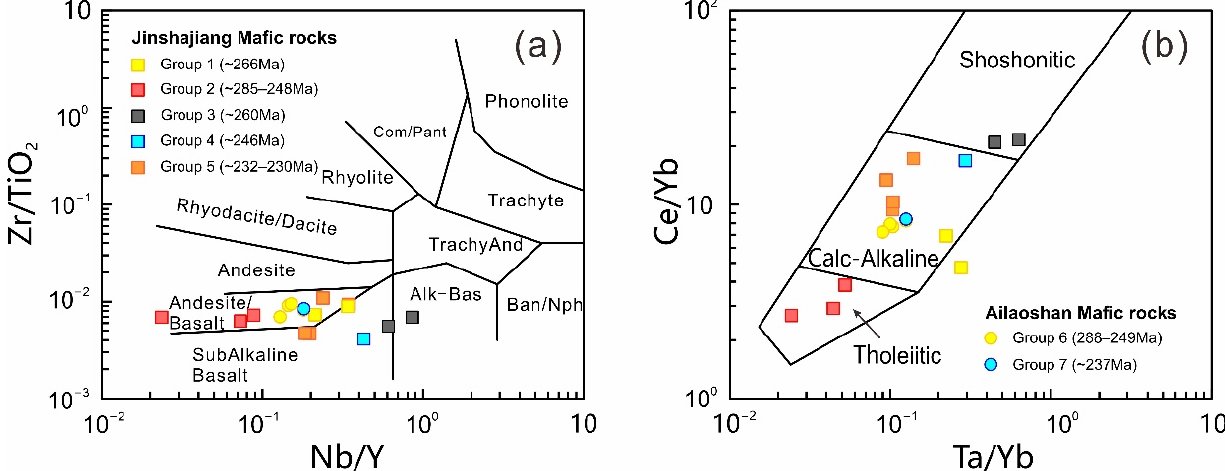
Figure 5. ( a ) Nb/Y vs. Zr/TiO 2 diagram [96] and ( b ) Ta/Yb vs. Ce/Yb diagram [97] for mafic and metamafic rocks from the JASB.